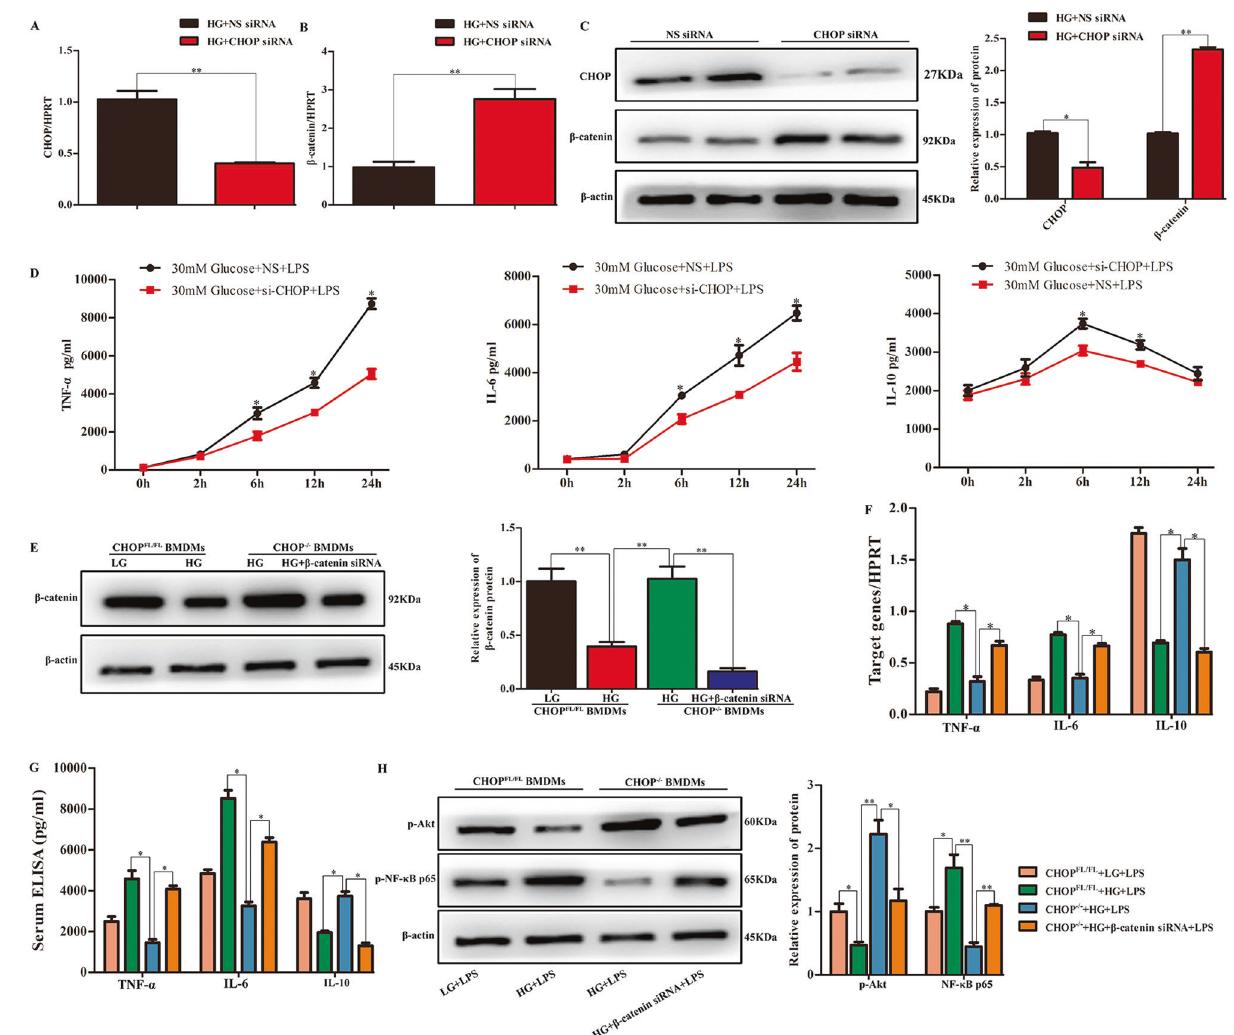
Fig. 7 β -Catenin negative regulation by CHOP was critical for HG-mediated in fl ammatory responses in macrophages. A , C CHOP in differentiated BMDMs cultured in HG conditions was inhibited by transfection of siRNA, and endogenous CHOP was validated by qRT-PCR and western blot. ** P < 0.01. B , C β -Catenin levels were increased after CHOP downregulation in hyperglycemia-stressed BMDMs, as shown by qRT- PCR and western blot. * P < 0.05, ** P < 0.01. D TNF- α , IL-6, and IL-10 concentration in culture supernatants were measured by ELISA at 0, 2, 6, 12, and 24 h. E Western blot detection of β -catenin expression in different groups of BMDMs with LPS (1 µg/ml) stimulation. F Quanti fi cation analysis of mRNAs of cytokines TNF- α , IL-6, and IL-10 (6 h). G Cytokine in supernatants was evaluated by ELISA (24 h). * P < 0.05. H Protein expression of p-Akt, p-NF- κ B p65, and β -actin (6 h) was analyzed using western blotting. * P < 0.05, ** P < 0.01. Data stand for three independent experiments with similar